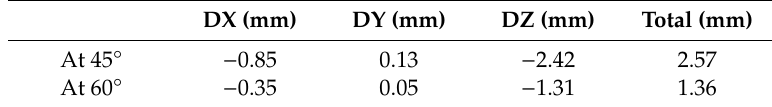
Table 13. Displacement in the support between the connecting rod and arches.